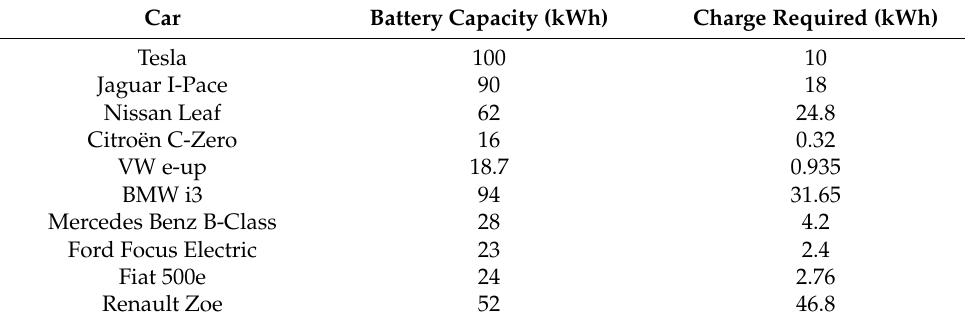
Table 4. Car charge level